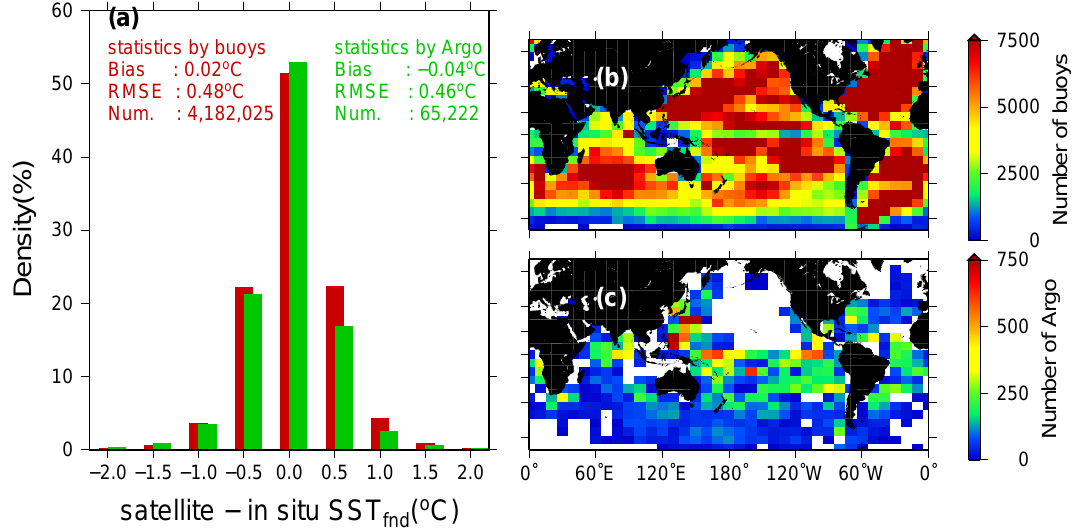
Figure 6. ( a ) Histograms of satellite-based foundation SST and in situ measurements (red: drifting buoy; green: Argo profiling floats). Statistics of these (bias, RMSE and the number of match-ups are summarized in the upper part of the figure. ( b , c ) Distributions of validation match-ups between drifting buoys ( b ) and Argo floats ( c ). The number of match-ups were calculated in a 5 ◦ × 10 ◦ (lat. × lon.) box. Their comparison periods are 2003–2015 ( b ) and 2012–2015,